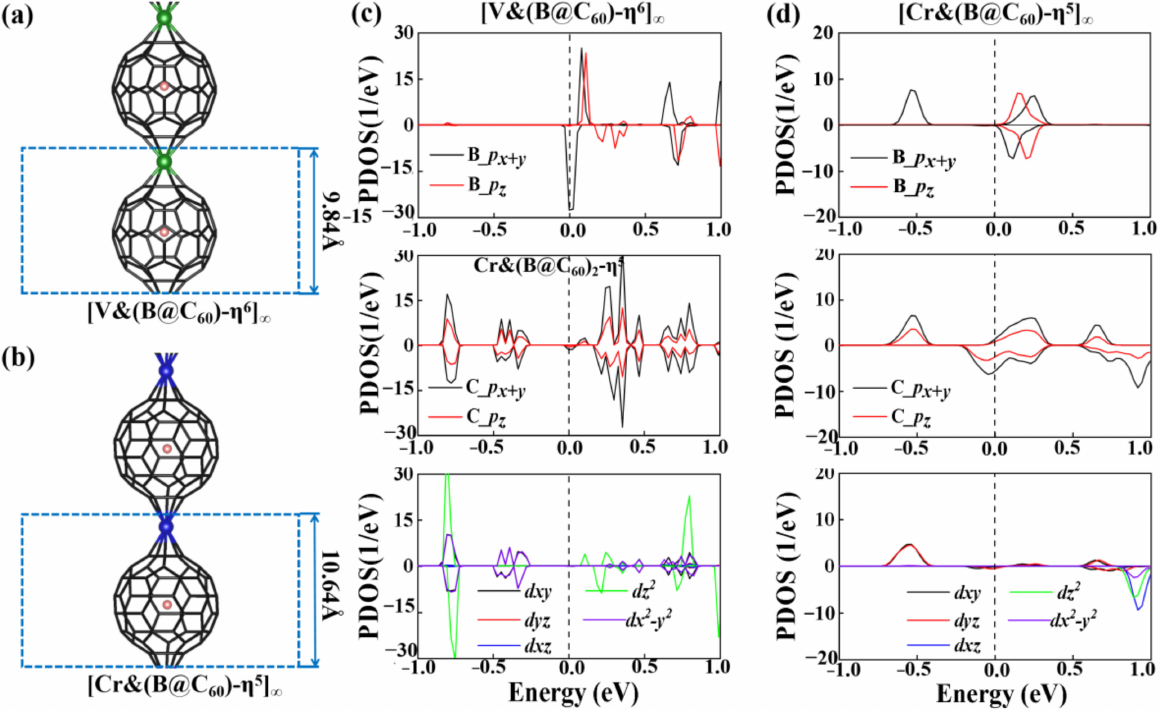
Figure 3. The optimized structures ( a , b ) and PDOS ( c , d ) of 1D [V&(B@C 60 )- η 6 ] ∞ and [Cr&(B@C 60 )- η 5 ] ∞